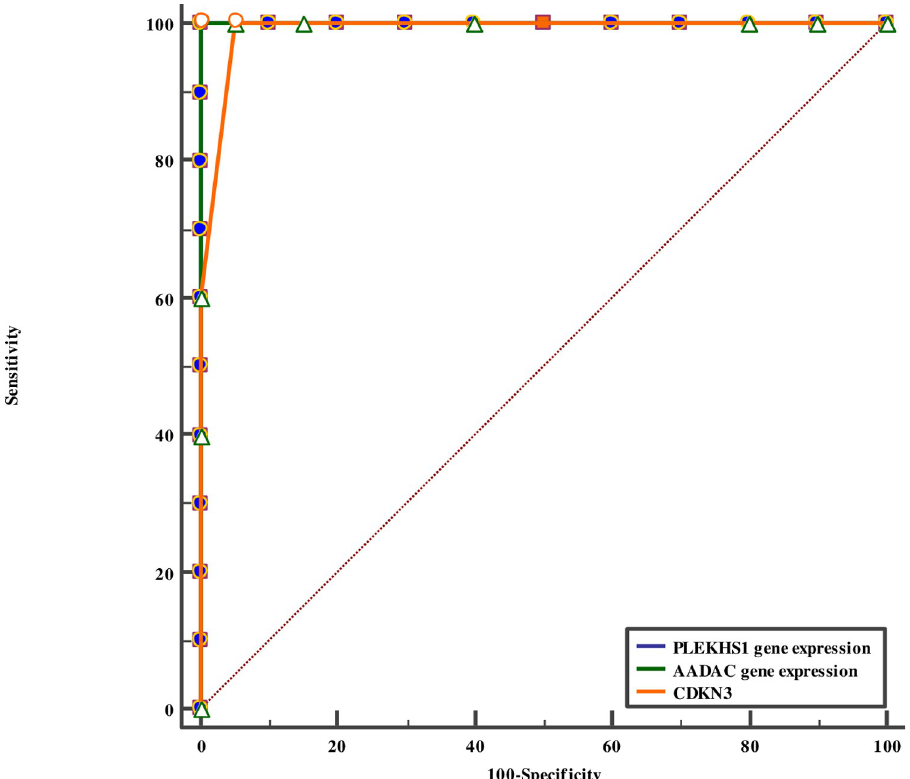
Fig 2. Comparison between PLEKHS1, AADAC, CDKN3 gene expressions in the prediction of the presence of gastric adenocarcinoma. PLEKHS1, AADAC, CDKN3 gene expressions showed high significant sensitivity and specificity in the prediction of the presence of